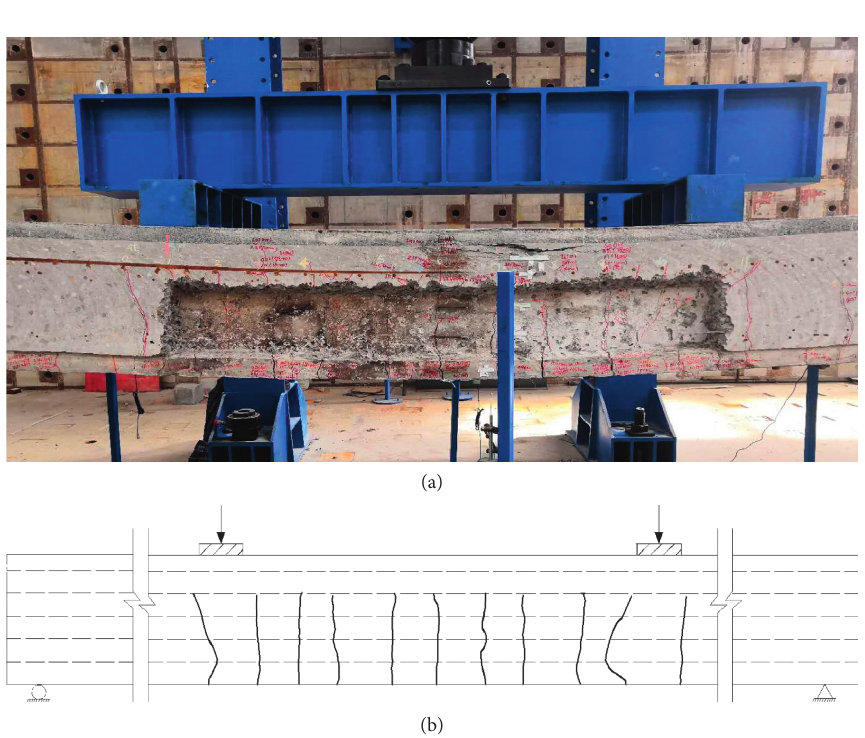
Figure 7: Failure shape and crack distribution of test beam: (a) failure shape; (b) crack distribution.